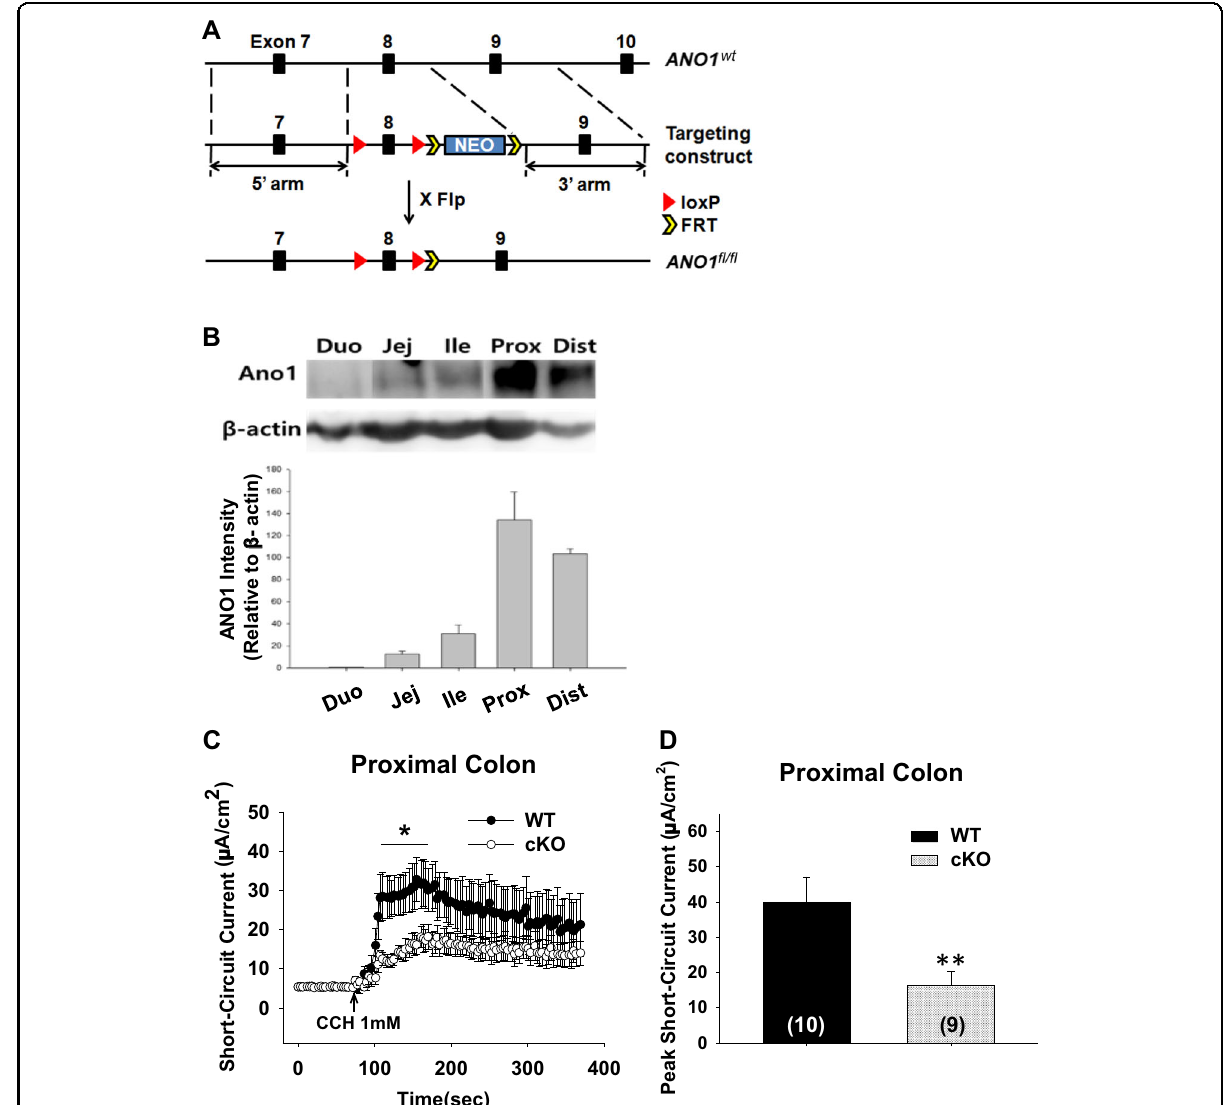
Fig. 1 Ablation of Ano1 from intestinal epithelial cells reduces carbachol-induced transepithelial Cl − currents. a Schematic diagram for the construction of the Ano1 fl / fl mice. Exon 8 of Ano1 was fl anked by loxp sites. The Ano1 fl / fl mice were crossed with Cdx2-cre transgenic mice to obtain Cdx2-Ano1 fl / fl mice. b Western blots of ANO1 in intestinal epithelial cells (IECs) isolated from intestinal segments in mice. IECs were prepared from each segment of the small and large intestines. Actin is a loading control. The whole blot is shown in Supplementary Fig. 3. The experiments were repeated four times. duo; duodenum, jej; jejunum, ile; ileum, prox; proximal colon, dist; distal colon. c Changes in short-circuit currents evoked by 1 mM carbachol applied to the serosal surface of the colon isolated from Ano1 fl / fl (wild-type, WT) and Cdx2-Ano1 fl / fl (conditional knockout, CKO) mice. To block Na + and K + currents, 100 μ M amiloride and 5 mM BaCl 2 were added to the mucosal and serosal sides, respectively. d Summary of peak short-circuit currents evoked by carbachol applied to the colon of WT and Cdx2-Ano1 fl / fl (CKO) mice. ** p < 0.01 and * p < 0.05. Error bars represent the standard error of the mean (SEM). The numbers in brackets represent the number of